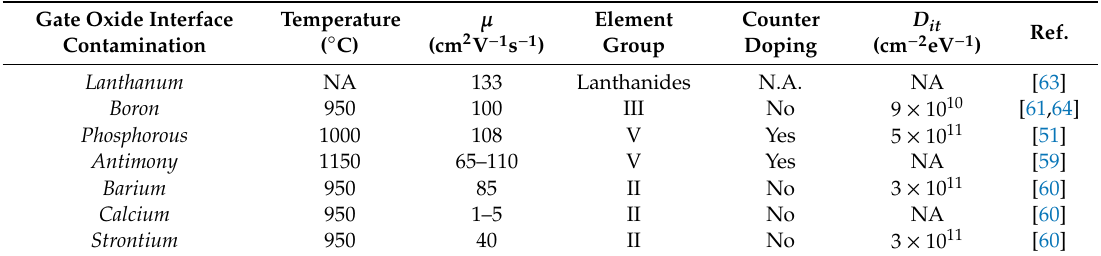
Table 4. Processes alternative to nitridation to reduce the D it and increase the MOSFET channel mobility.